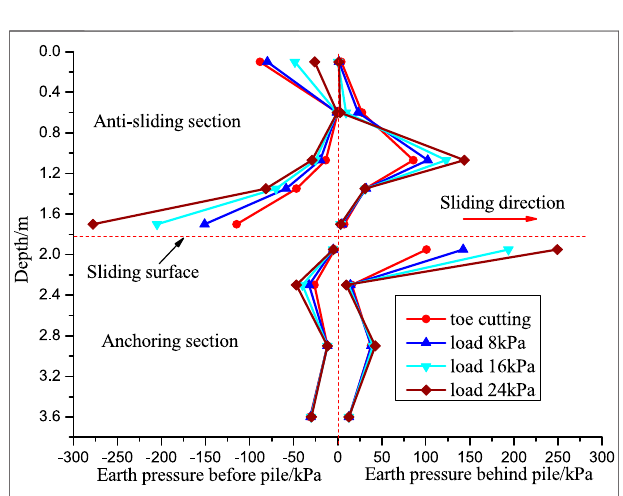
FIGURE 8 | Distribution of the earth pressure on pile